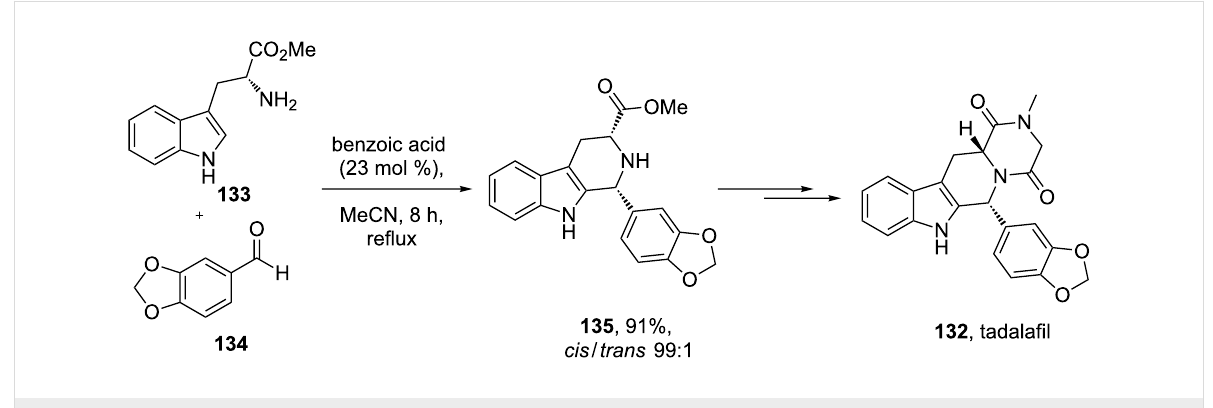
Scheme 28: Optimised Pictet–Spengler reaction towards